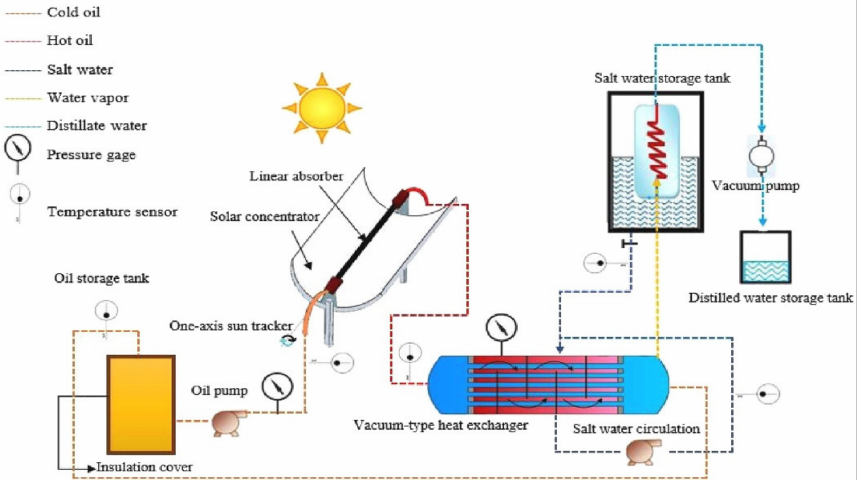
Figure 1. Schematic diagram of solar distillation system integrated with PTC and vacuum-type HE [55].